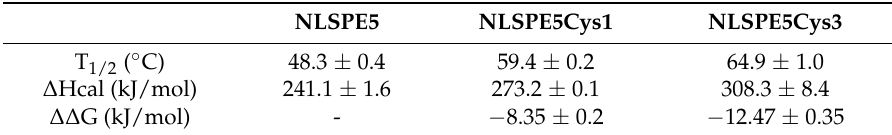
Table 2. Thermodynamic parameters of the temperature unfolding of the variants at pH 5.0 using Differential Scanning Calorimetry.